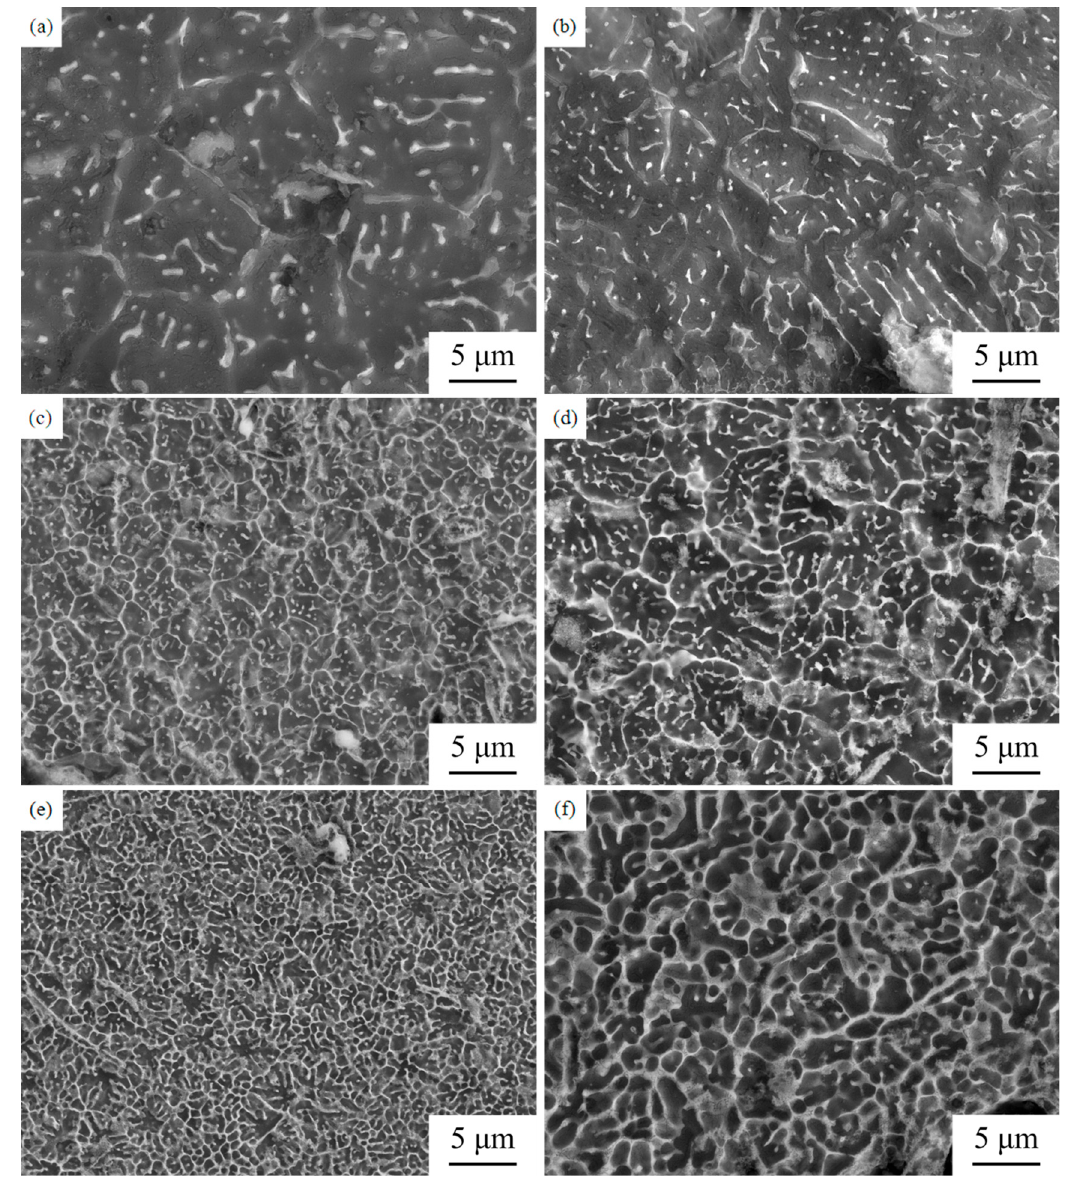
Figure 7. SEM micrographs of the molten pool of the LAMed porous Mg-Zn-Zr alloys. ( a ) E1 (Cross section), ( b ) E1 (Longitudinal section), ( c ) E2 (Cross section), ( d ) E2 (Longitudinal section), ( e ) E3